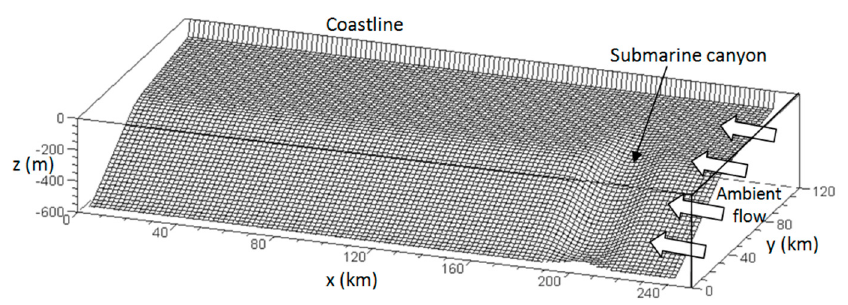
Figure 1. Idealized bathymetry used in the control experiment of this study.